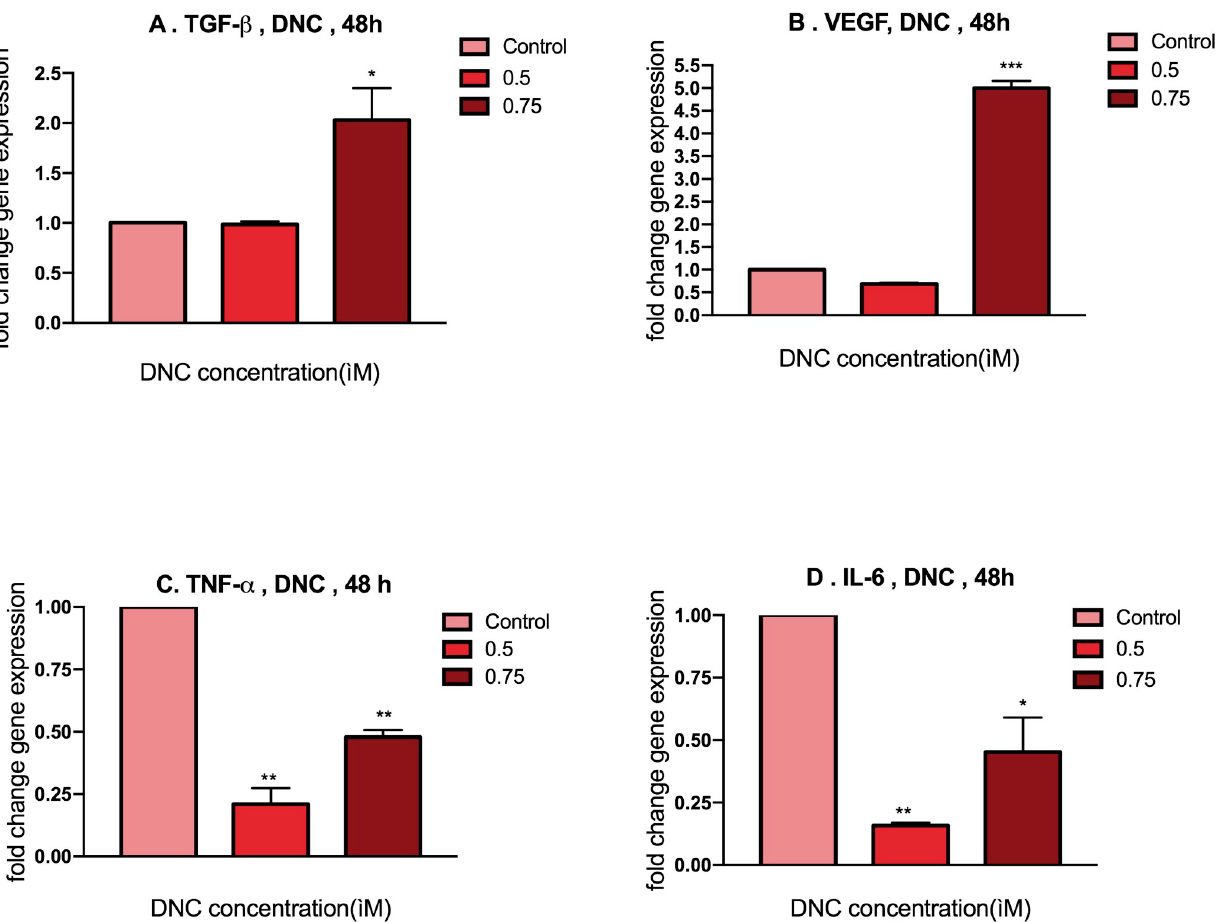
Fig 2. TGF- β , VEGF, TNF- α , IL-6 genes expression in MEFs under 48h treatment with doses of 0.5, 0.75 μ M DNC. Charts Represents a significant increase in TGF- β (A) and VEGF (B) and a significant decrease in TNF- α (C) and IL-6 (D) gene expression in MEFs compared with control group. Data are shown as mean ± SEM; n = 3 ( � : p < 0.05, �� p: < 0.01, ��� p: <